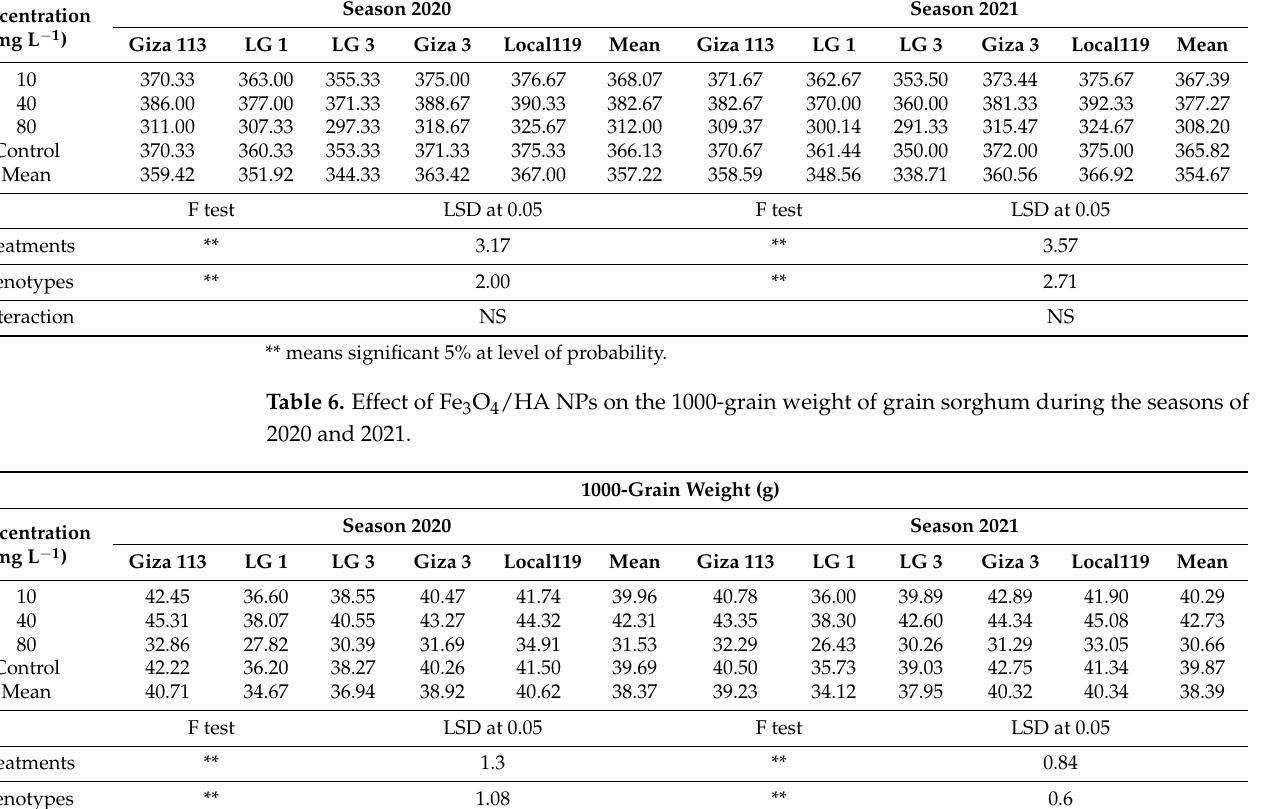
Table 5. Effect of Fe 3 O 4 /HA NPs on plant height of grain sorghum during the seasons of 2020 and 2021. Plant Height (cm)